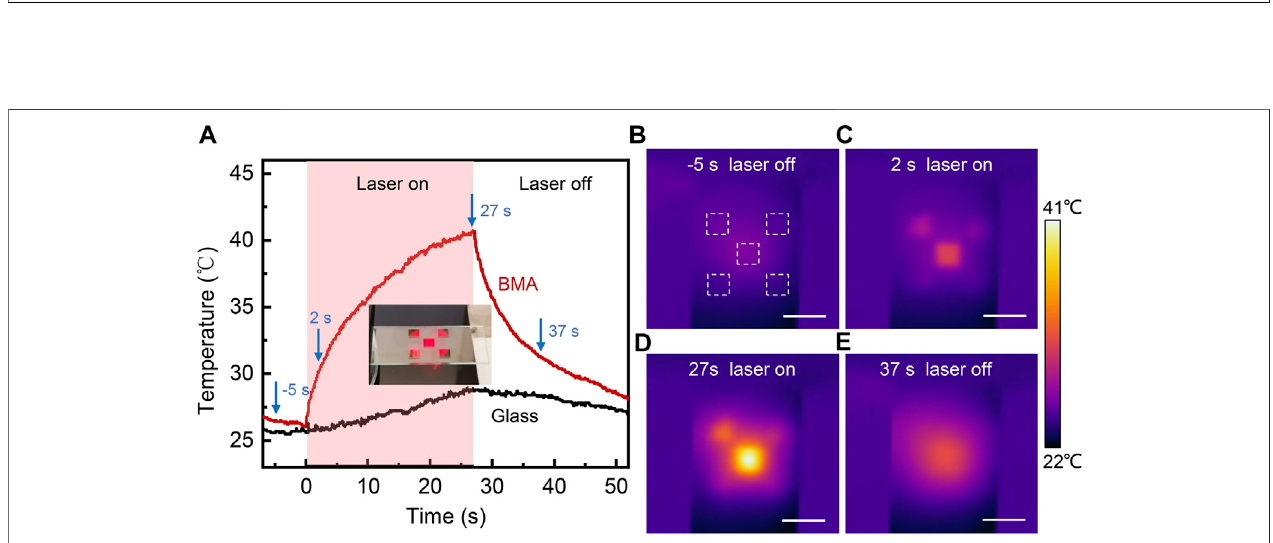
FIGURE 7 | Photothermal conversion by the BMAs. (A) Central temperature of the BMA and glass slide as a function of time. Thermal images captured at (B) 5 s, (C) 2 s, (D) 27 s, and (E) 37 s.